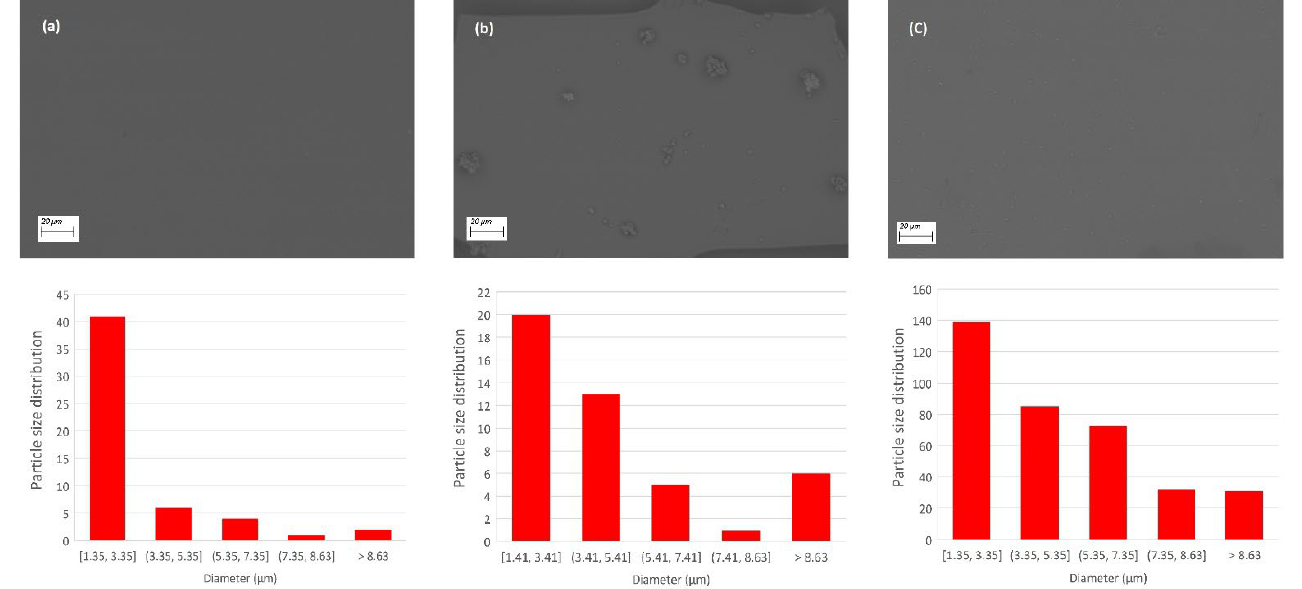
Figure 6. Photomicrographs at 1250× of iodine-doped thin films of ( a ) CuPc, ( b ) CoPc and ( c ) ZnPc.